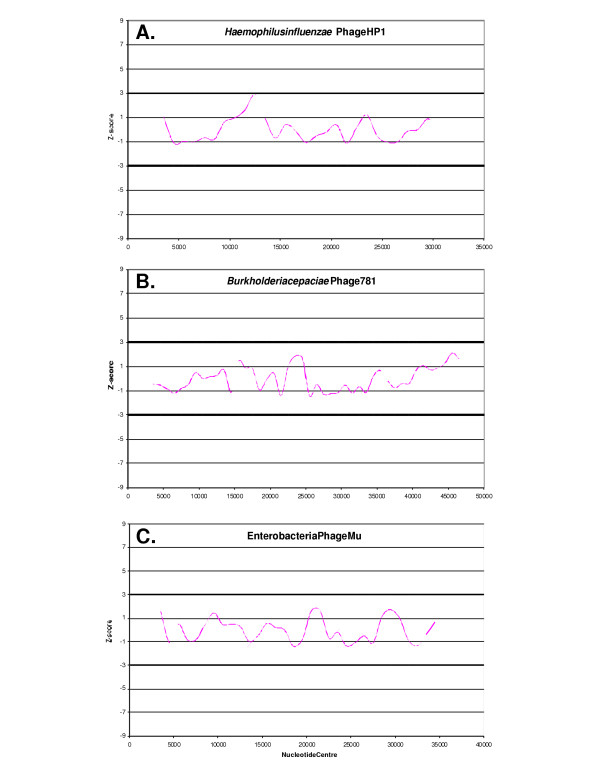
Tetranucleotide difference analysis of representative bacteriophage genomes (H. influenzae phage HP1, B. cepaciae phage 781, and Enterobacteria phage Mu). Tetranucleotide differences were determined with window and step sizes of 5,000 and 1,000, respectively, and Z-scores were determined as described in Materials and Methods. Solid black lines represent Z-scores of ± 3.